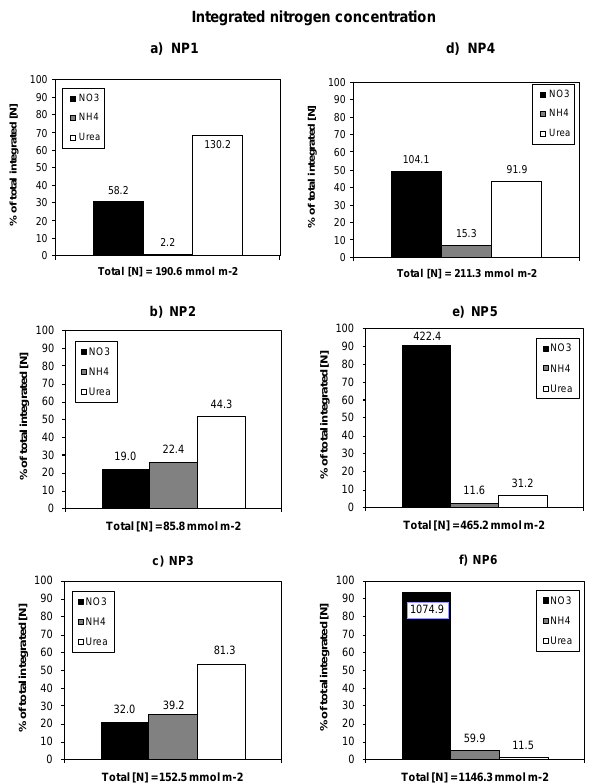
Fig. 5. (a–f) Nitrate, ammonium and urea (mmolm − 2 ) concen- trations integrated (to the 1% light depth for NP1 and 0.1% for NP2–NP6) and represented as a percentage of the total ambient nitrogen (NO 3 +NH 4 +urea), for each of the six productivity sta- tions. Numbers at the top of each bar represent the integrated nutri- ent concentration for each nutrient, with the total N concentration (NO 3 +NH 4 +urea) at the bottom of each figure.